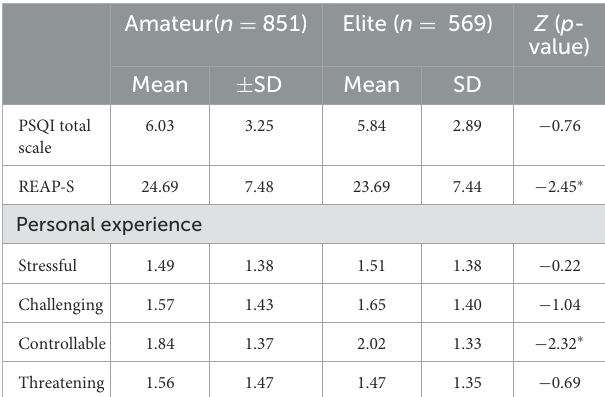
TABLE 2 Results of the Mann–Whitney test for the PSQI, REAP-S, and personal experience during the COVID-19 pandemic in amateur and elite